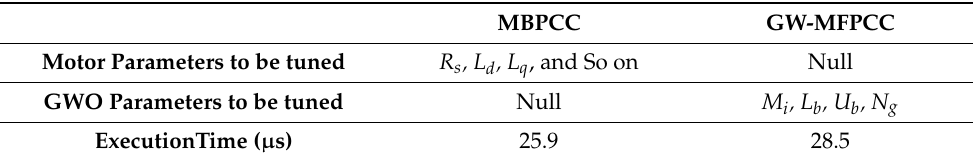
Table 2. Implementation complexity comparison of the MBPCC and GW −